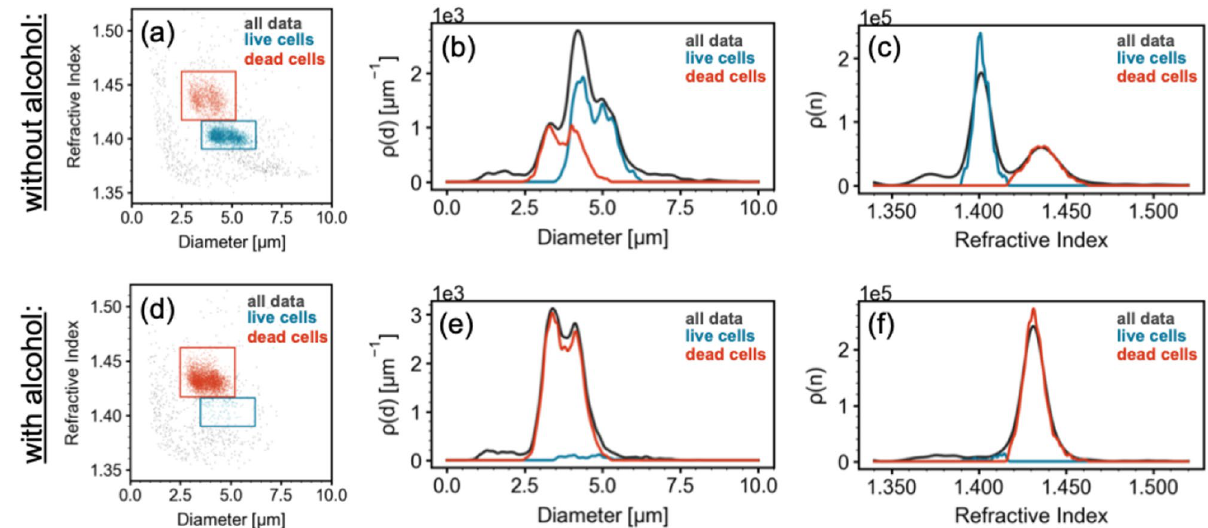
Figure 2. ( a ) A scatter plot of size on the horizontal axis and refractive index on vertical axis for a yeast sample before the addition of alcohol. Each point on the plot represents a single particle that flowed through the viewing region of the microfluidic chip during THC analysis. The colored boxed are user-defined regions of interest. The points colored in orange represent dead yeast cells and the points colored in cyan represent live yeast cells. Particles outside of the user-defined boxes are colored gray. ( b ) Density distributions of particle size for the sample shown in ( a ). The orange, cyan and gray curves represents the size density distributions of dead cells, live cells, and all particles respectively. The area under each curve for a given size range represents the number of particles (of the species represented by that curve) in that size range. The peak of each curve shows the most common size of each particle type. ( c ) Density distributions of particle refractive index for the sample shown in ( a ). The coloring is the same as in ( b ). The area under each curve for a given refractive index range represents the number of particles (of the species represented by that curve) in that refractive index range. The peak of each curve shows the most common refractive index of each particle type. ( d )–( f ) Scatter plot, size density plot, and refractive index density plot as in ( a )–( c ) but for a yeast sample that was exposed to 15% isopropanol by volume for 71